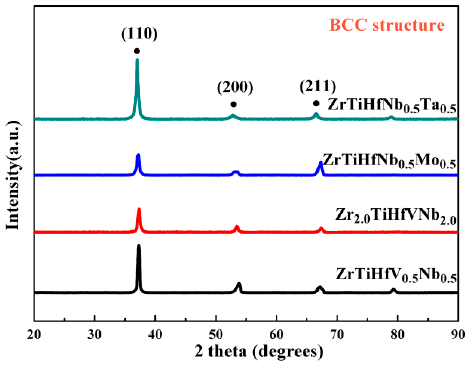
Figure 1. X-ray diffraction patterns of the refractory high-entropy alloys (RHEAs). Table 1. The relevant thermodynamic parameters and valence electron concentration (VEC) of the refractory alloys.